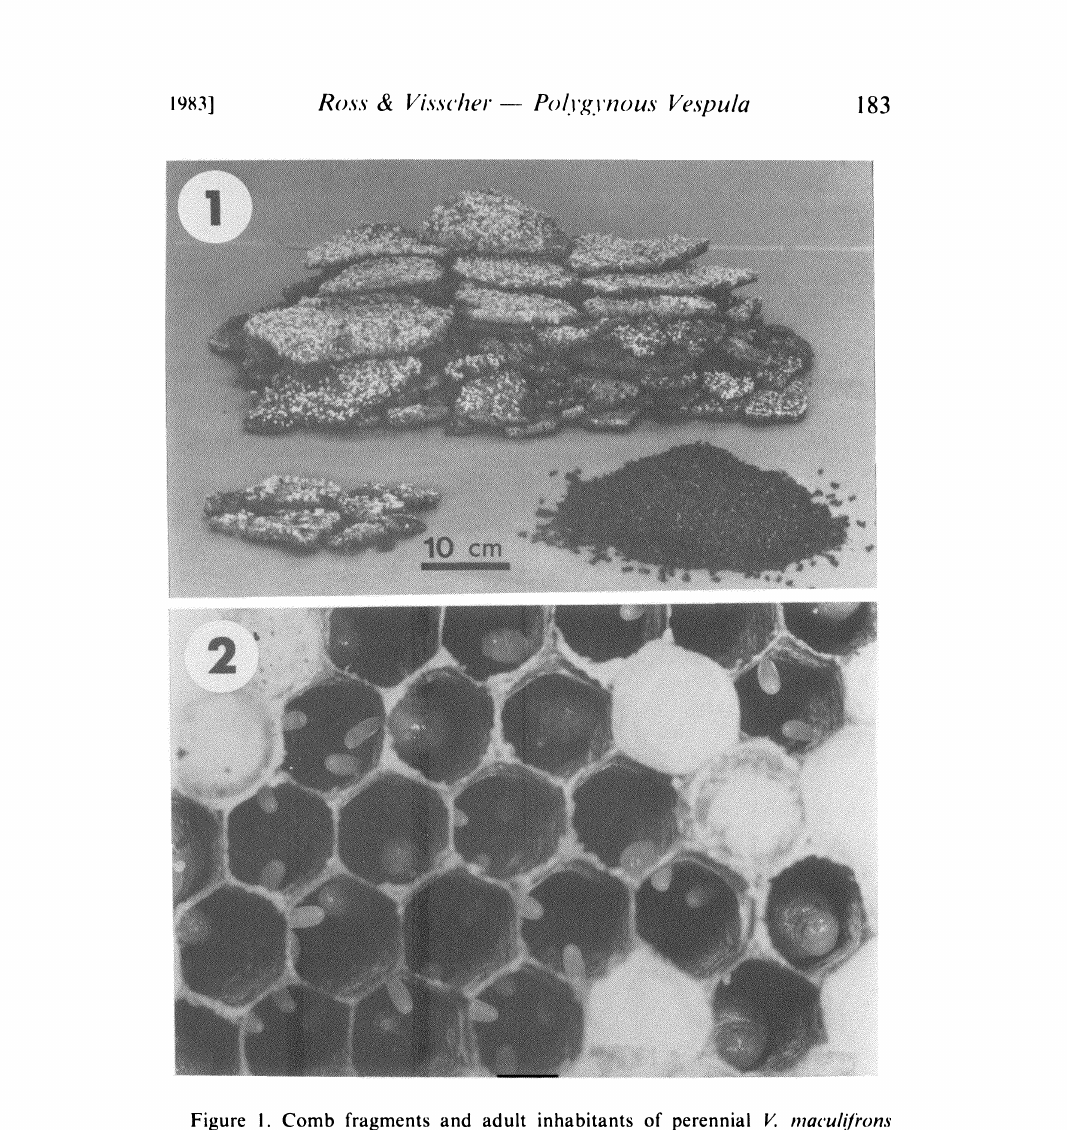
Figure I. Comb fragments and adult inhabitants of perennial V. macul(/’rons colony. Combs positioned in left foreground contain large cells. Figure 2. Supernumerary eggs and immatures in small cells of perennial V. maculi- frons colony. Note positions of eggs high on the cell